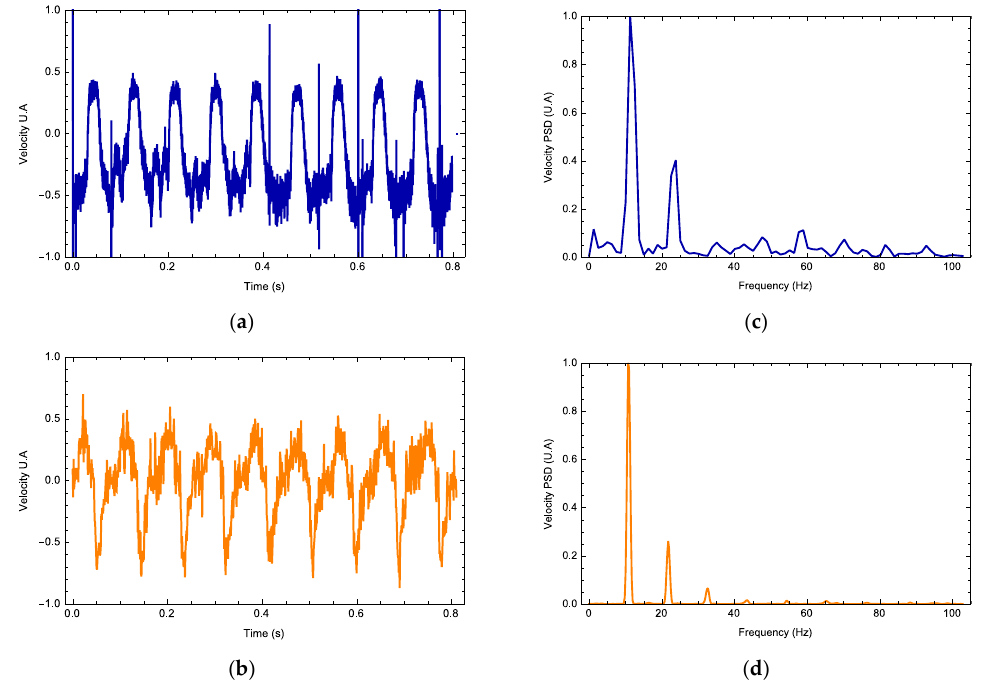
Figure 5. Photodyne movement velocity ( a , b ) and Fourier spectrum ( c , d ). Comparison of the theoretical (orange) and experimental results (blue). Sinusoidal signal, input frequency of 10 Hz. Calculated value of h = 27.1 and n ligth = 0.50.